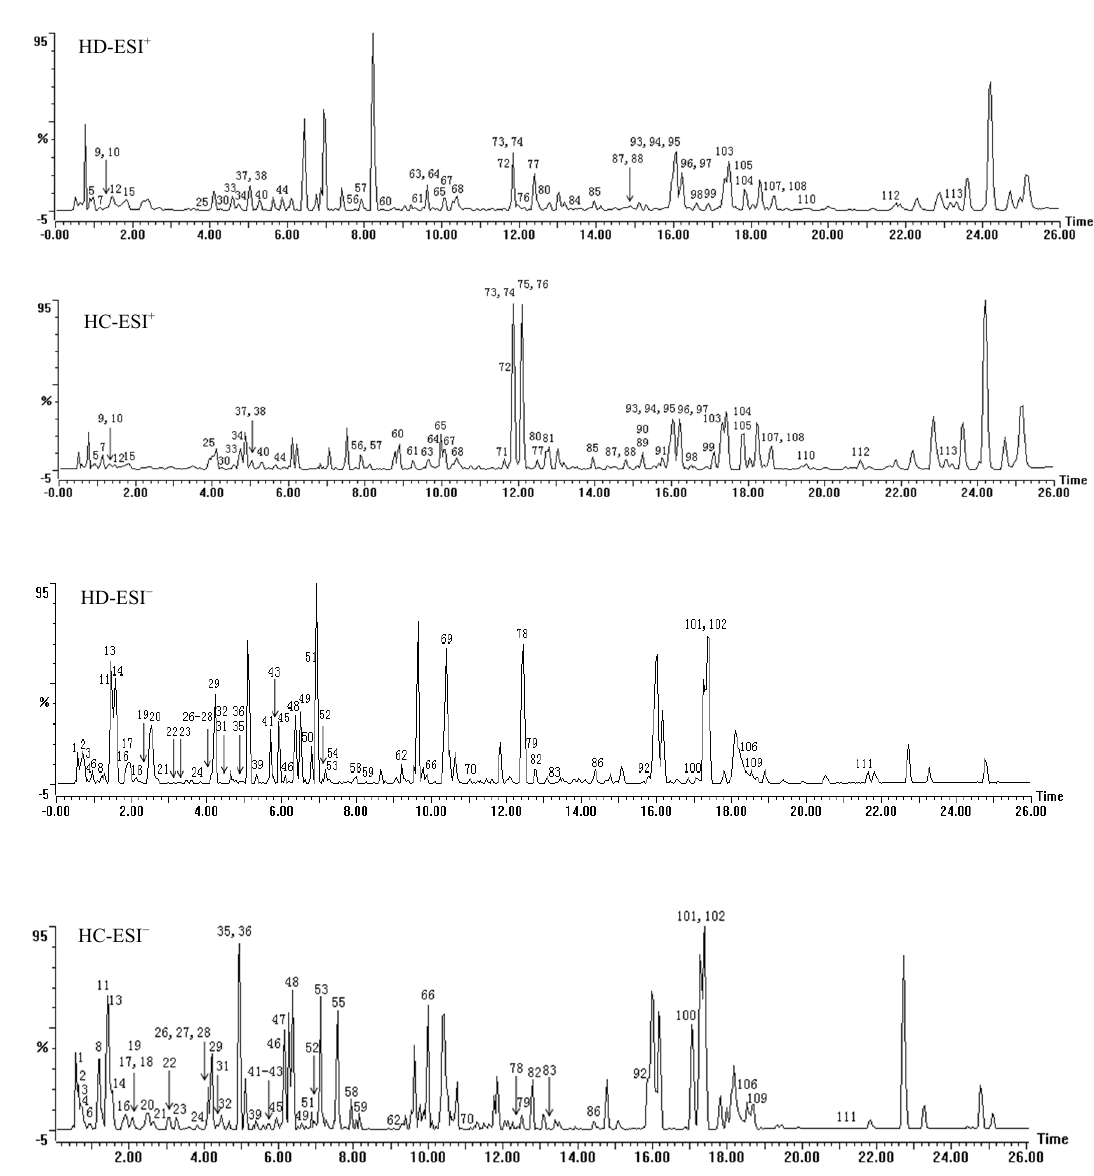
Figure 1. The representative base peak intensity (BPI) chromatograms of HD and HC in positive mode (ESI + ) and negative mode (ESI − ). (The character “,” represent the meaning of “and”).